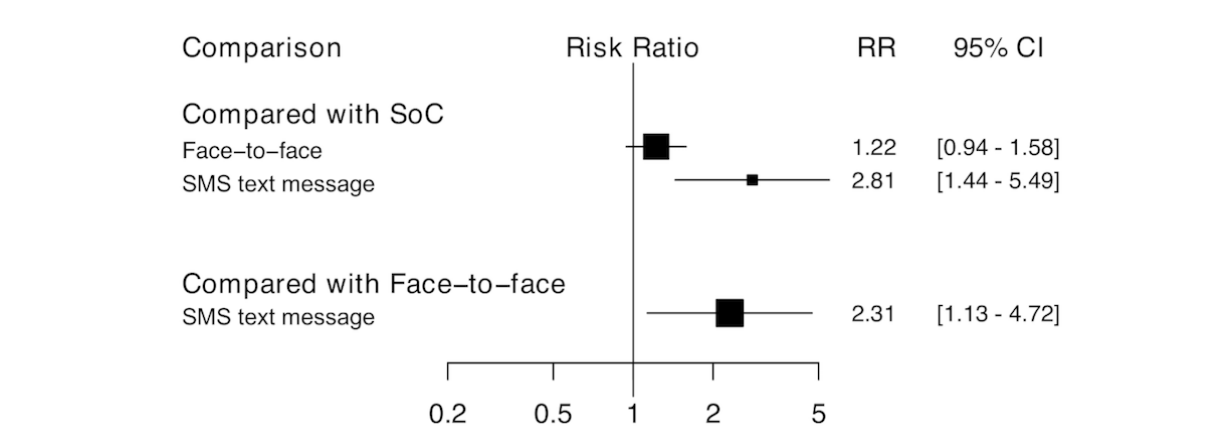
Figure 5. Pairwise comparisons of all interventions, short-term effect. RR: risk ratio; SMS: short message service; SoC: standard of care, no intervention control.